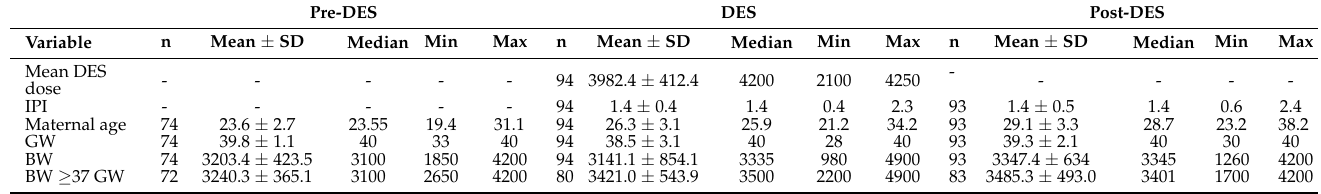
Table 2. Characteristics of G0 mothers and G1 children in function of their DES exposure status.